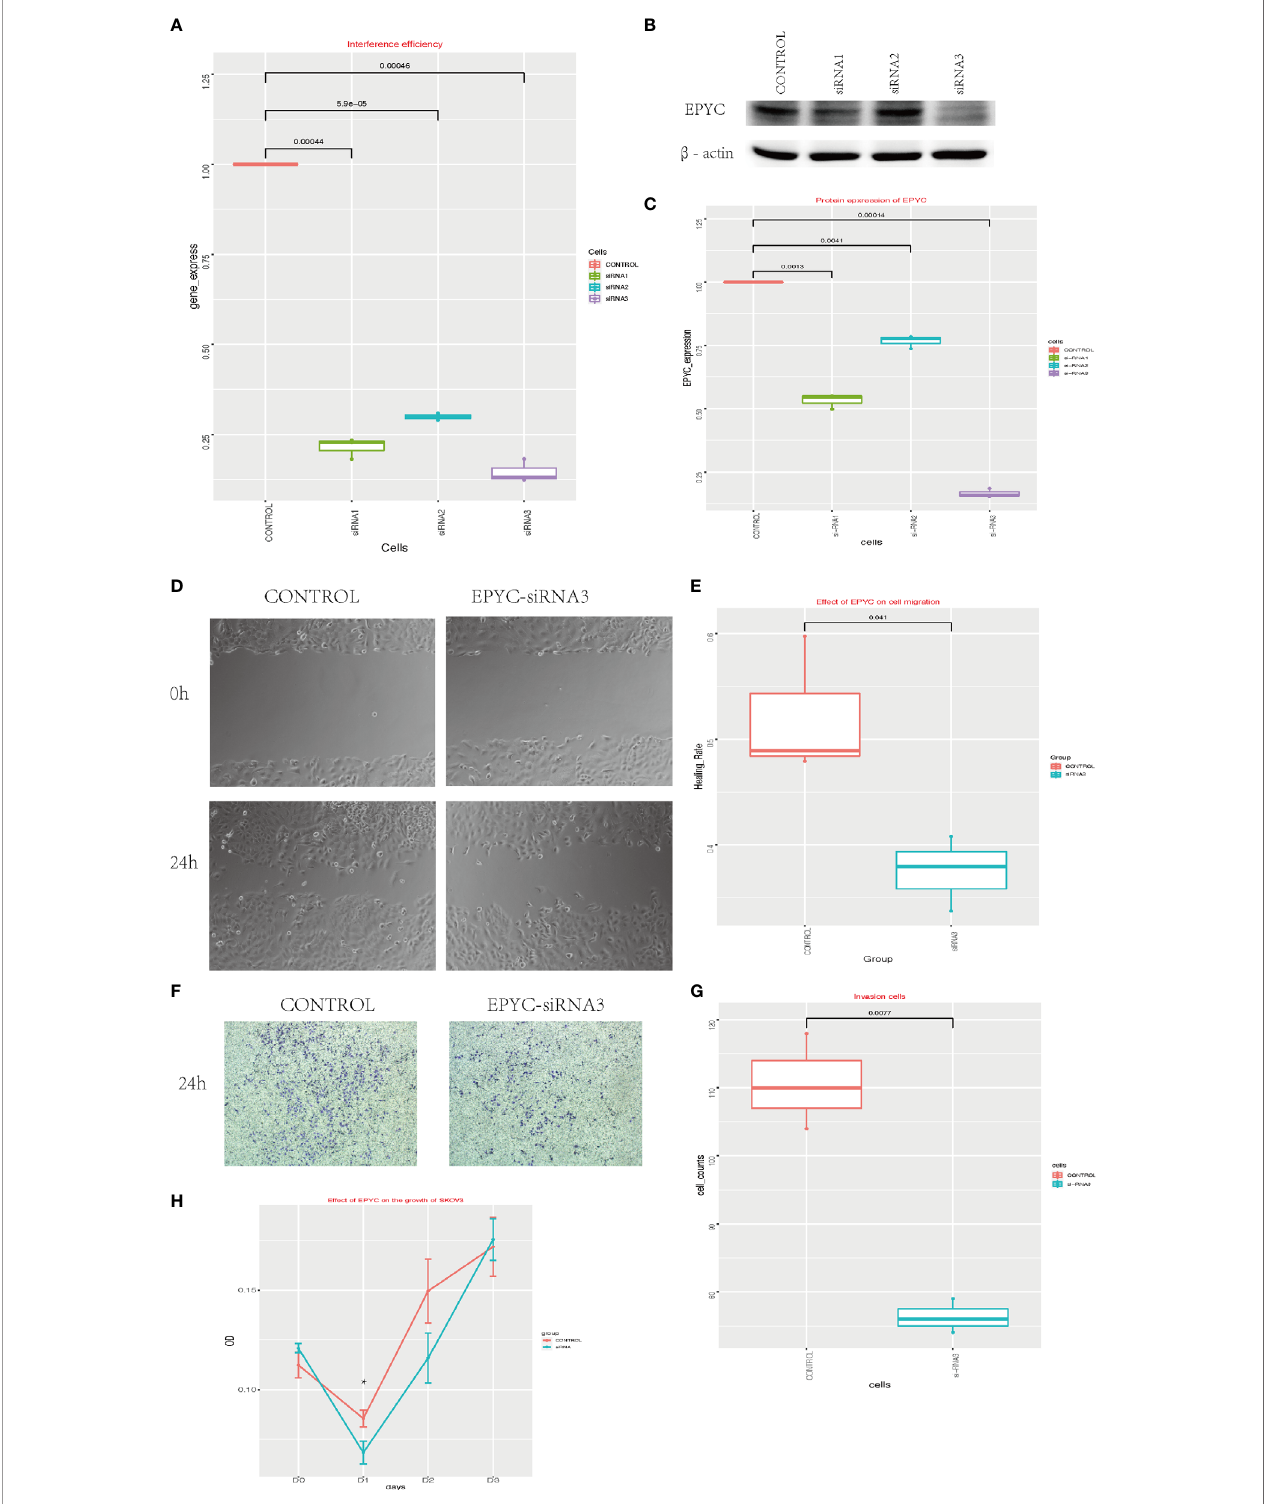
FIGURE 3 | The function of EPYC. (A) EPYC mRNA expression detected by real-time qPCR after EPYC-siRNAs interfering. (B, C) EPYC protein expression detected by western blot. (D, E) Effect of EPYC on SKOV3 migration. (F, G) Effect of EPYC on SKOV3 invasion. (H) Effect of EPYC on SKOV3 growth. * means after 24 hours, the OD value was signi fi cantly lower in EPYC-siRNA group than the control group, detected by CCK8, p <